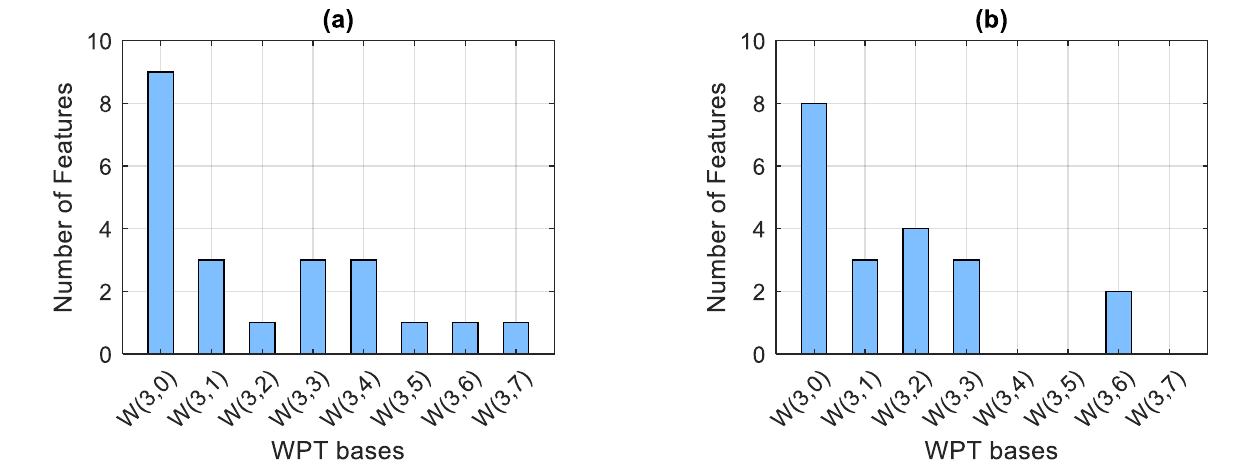
Figure 9. Number of features selected by the Boruta algorithm from each WPT node: ( a ) Dataset with artificial damages; ( b ) Dataset with real damages.